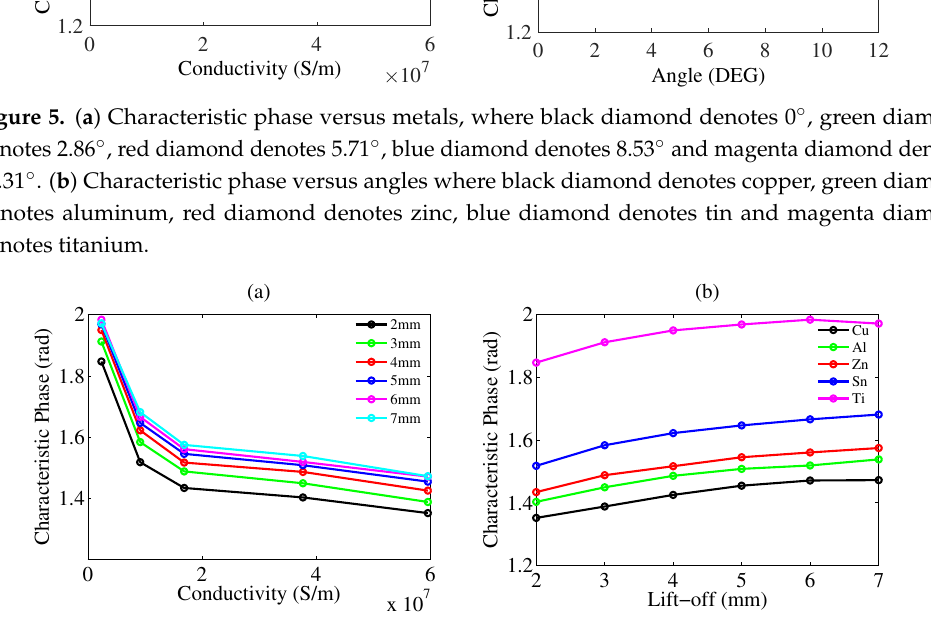
Figure 6. ( a ) Characteristic phase versus conductivity for different lift-off values. ( b ) Characteristic phase versus different lift-off values for different